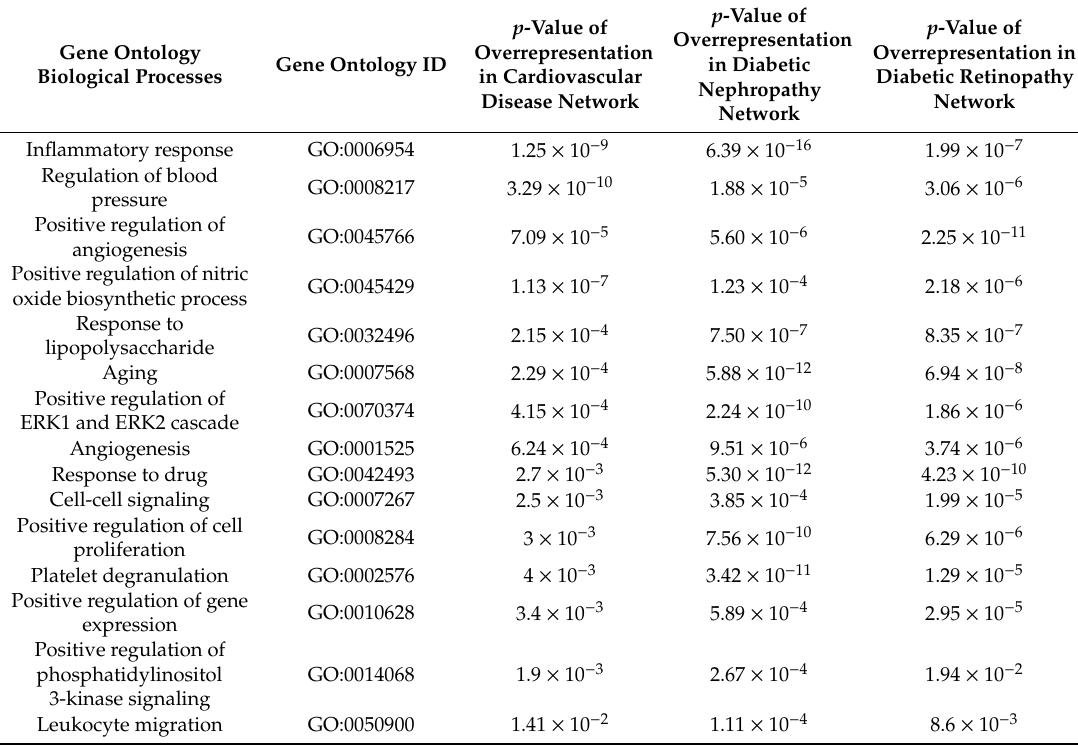
Table 4. GO biological processes overrepresented ( p -values with FDR correction < 0.05) for genes that are regulated by GV-related genes and participate in the gene networks of cardiovascular disease, diabetic nephropathy, and diabetic retinopathy.